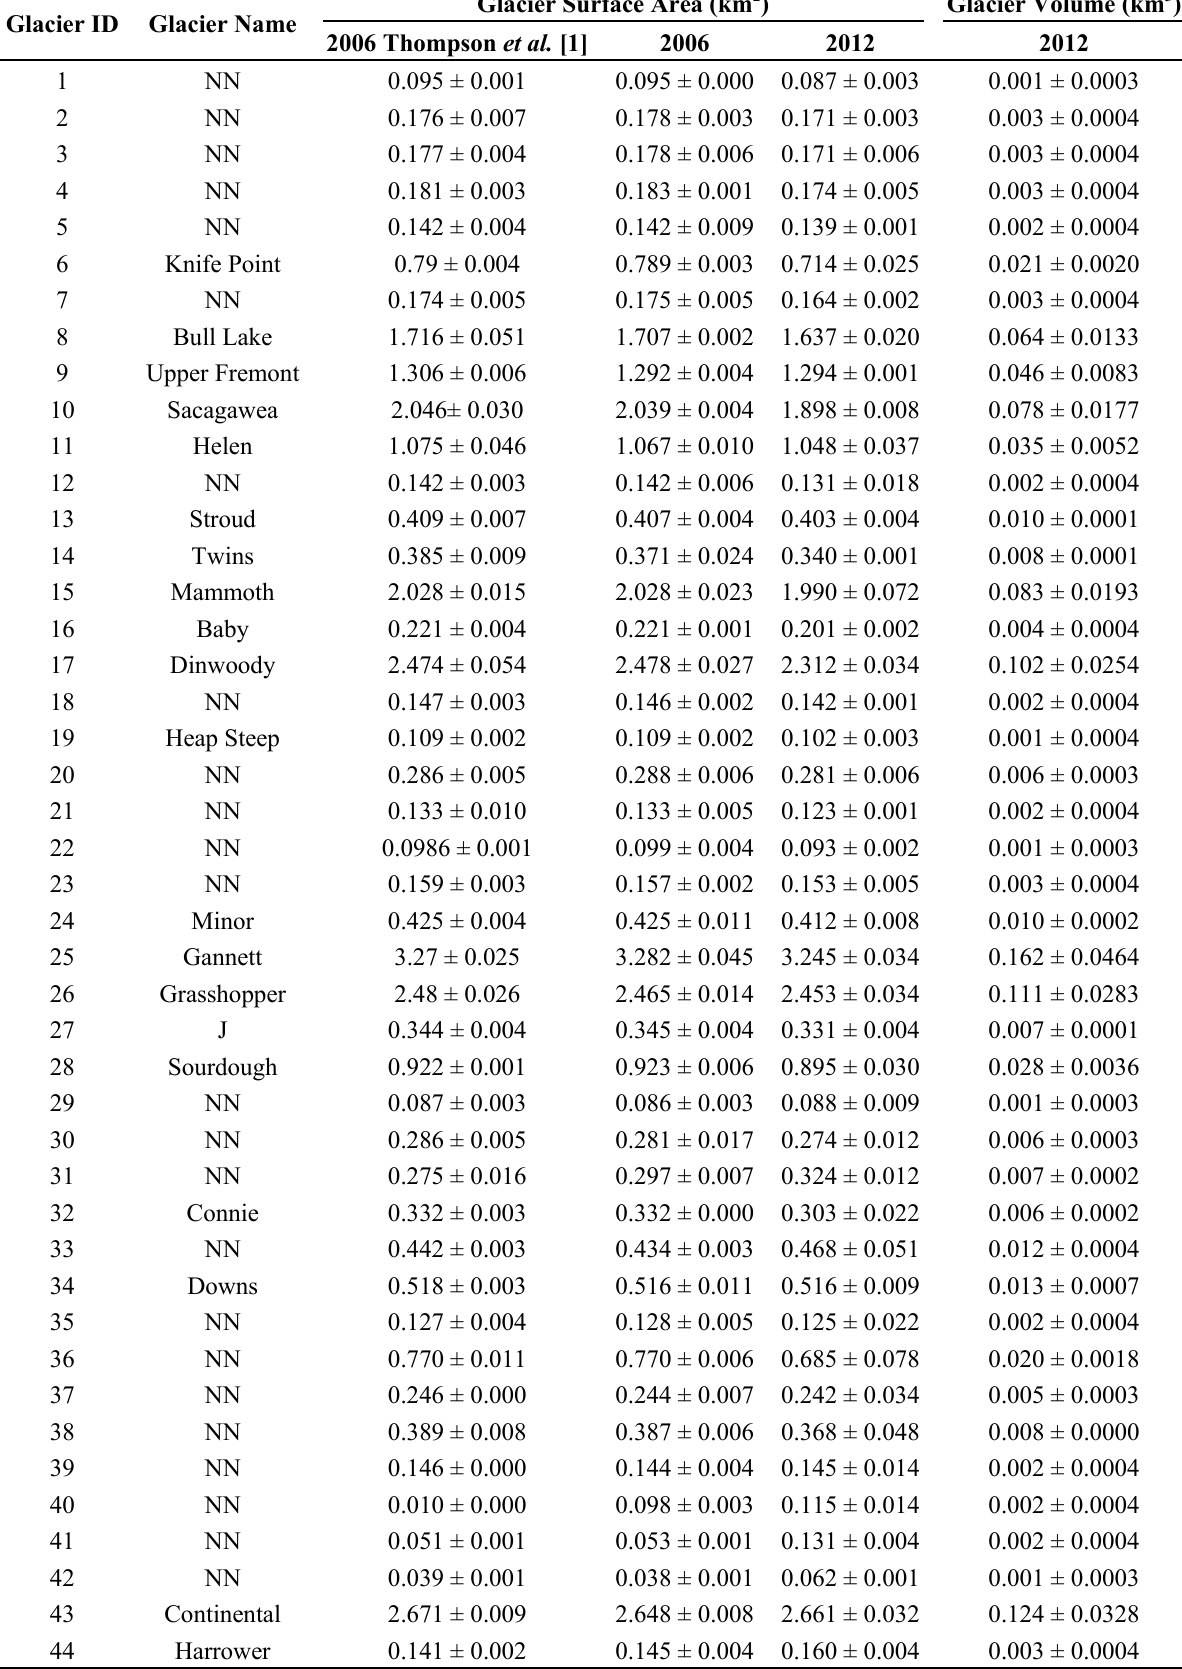
Table 1. Glacier surface areas (km 2 ) and volumes (km 3 ) in the Wind River Range (2006 and